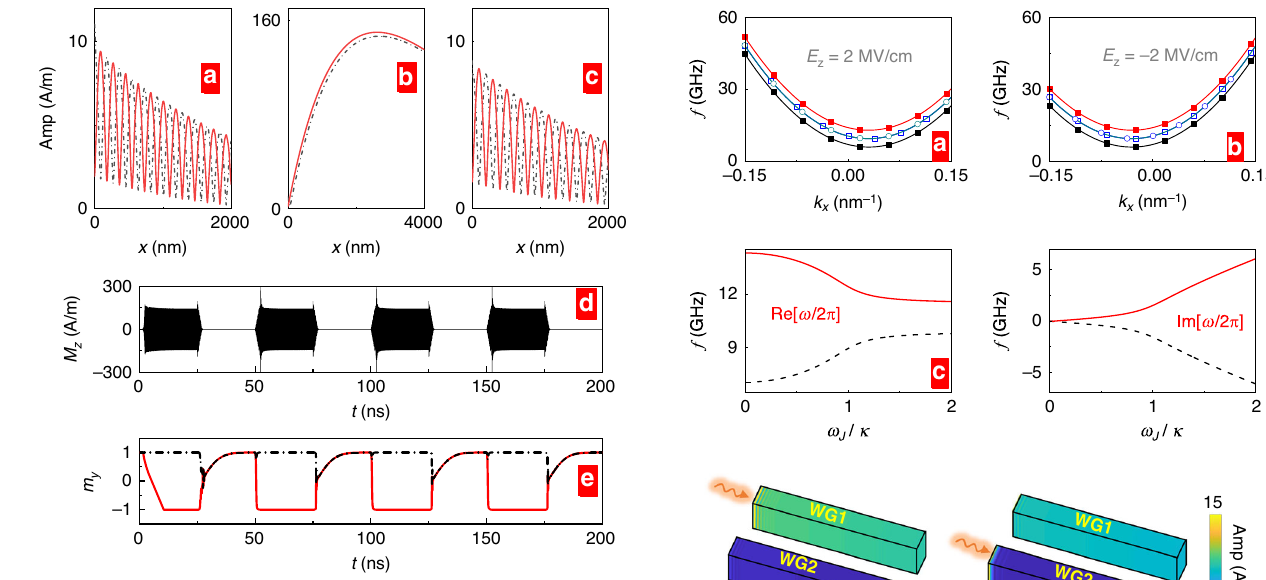
Fig. 5 EP quenching. When exciting spin waves of frequency 20 GHz at x = 0 in WG1, the spatial pro fi les of spin-wave amplitudes are shown for a ω = 0, b ω = κ with H = 2 × 10 5 A/m applied along + y , and c ω = κ with J J 0 J Fig. 6 In fl uences of DM interaction. Control of the coupled magnonic H = 2 × 10 5 A/m applied along + x . Black dashed line and red solid line 0 waveguides characteristics by external electric fi elds in the presence of represent the amplitudes in WG1 and WG2, respectively. d Time dependent Dzyaloshinskii – Moriya interaction. a , b Applying a static electric fi eld of M z is detected at x = 3000 nm in WG1 when the charge current ω J is E 1,2 = (0, 0, E z ) with E z = ±2 MV/cm to both waveguides modi fi es the periodically switched on ( ω J = κ ) and off ( ω J = 0). e Time dependent of m y magnon dispersion Re ½ ω (cid:2)ð k x Þ curves for ω J = 0 (solid dots) and ω J = κ of WG1 and WG2 when the charge current ω J is periodically switched on (open dots). c Real and imaginary parts of the two eigenmodes ω as ( ω J = 1.05 κ ) and off ( ω J = 0). functions of ω J and in the presence of two static electric fi elds (or voltages) (Fig. 5e), which is of relevance to magnetic tunnel junctions applied with opposite polarity to both waveguides ( E 1 = (0, 0, E z ) and whose magneto conductance depends on the relative orientation E 2 = (0, 0, − E z ), and E z = 2 MV/cm) at k x = 0.1 nm − 1 . d Spatial pro fi les of of the layers ’ magnetizations. the propagating spin-wave amplitudes when applying the electric fi eld to WG1 ( E 1 = (0, 0, E z ) with E z = 2 MV/cm, and E 2 = (0, 0, 0)). Color scale from blue to red corresponds to an amplitude change from 0 to its